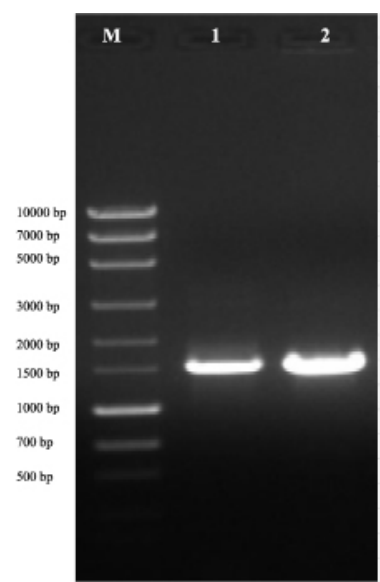
Fig. 6. Extracted DNA quality check on 1.0% agarose gel electrophoresis. M-1Kb DNA ladder, 1- λ DNA 200ng, 2- HYJE003 and 3- HYJE005